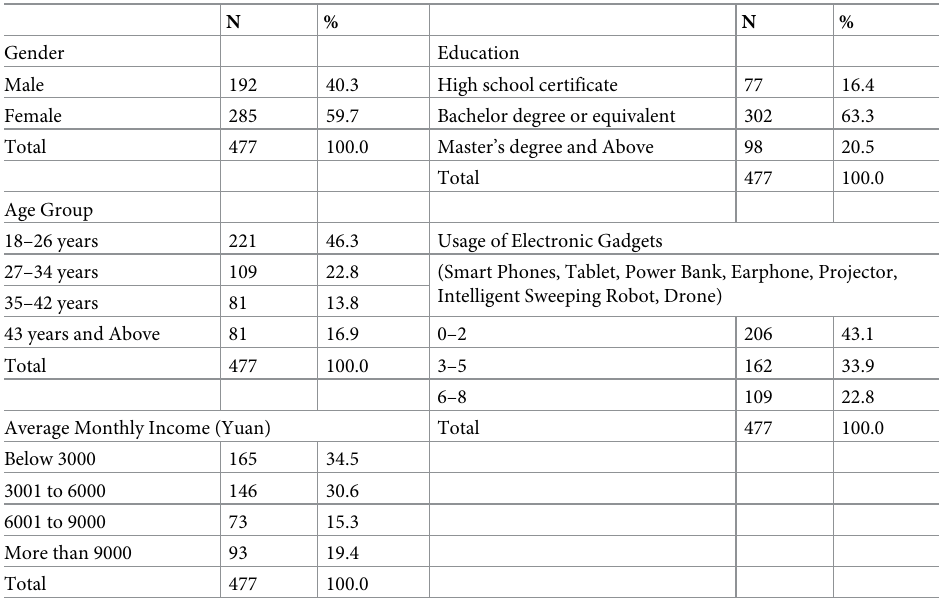
Table 2. Demographic